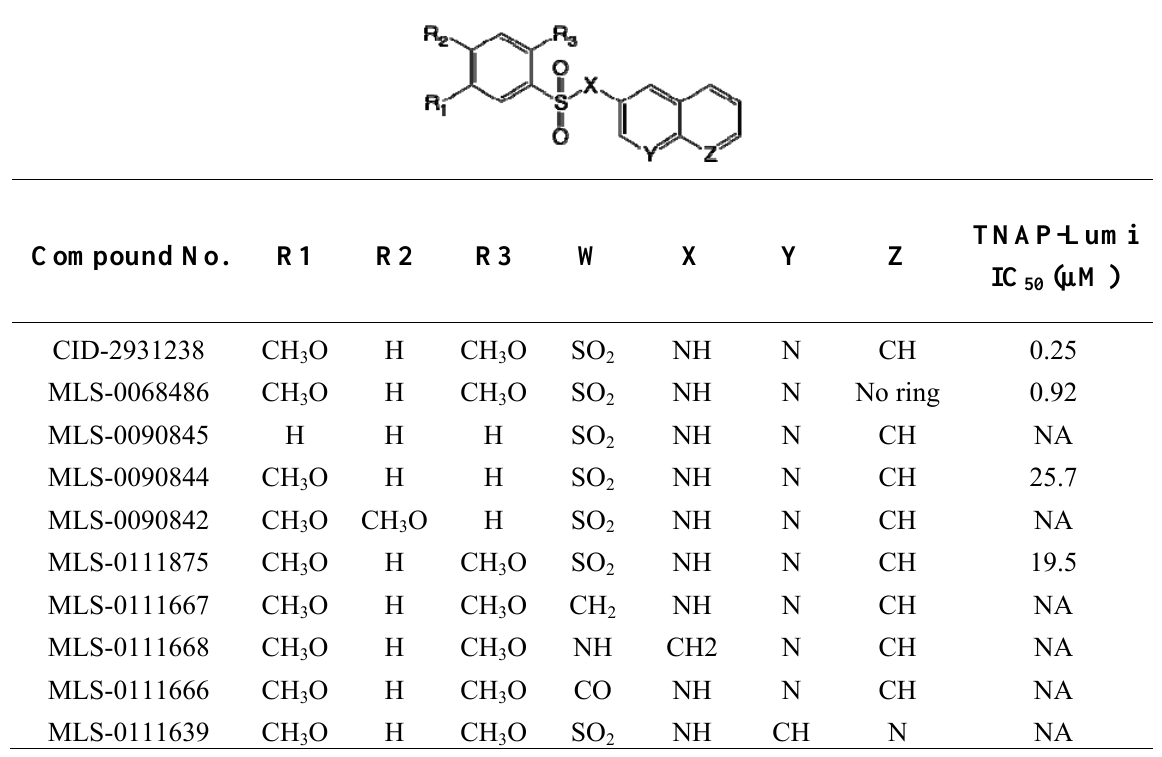
Table 5. SAR of the bisarylsulfonamide